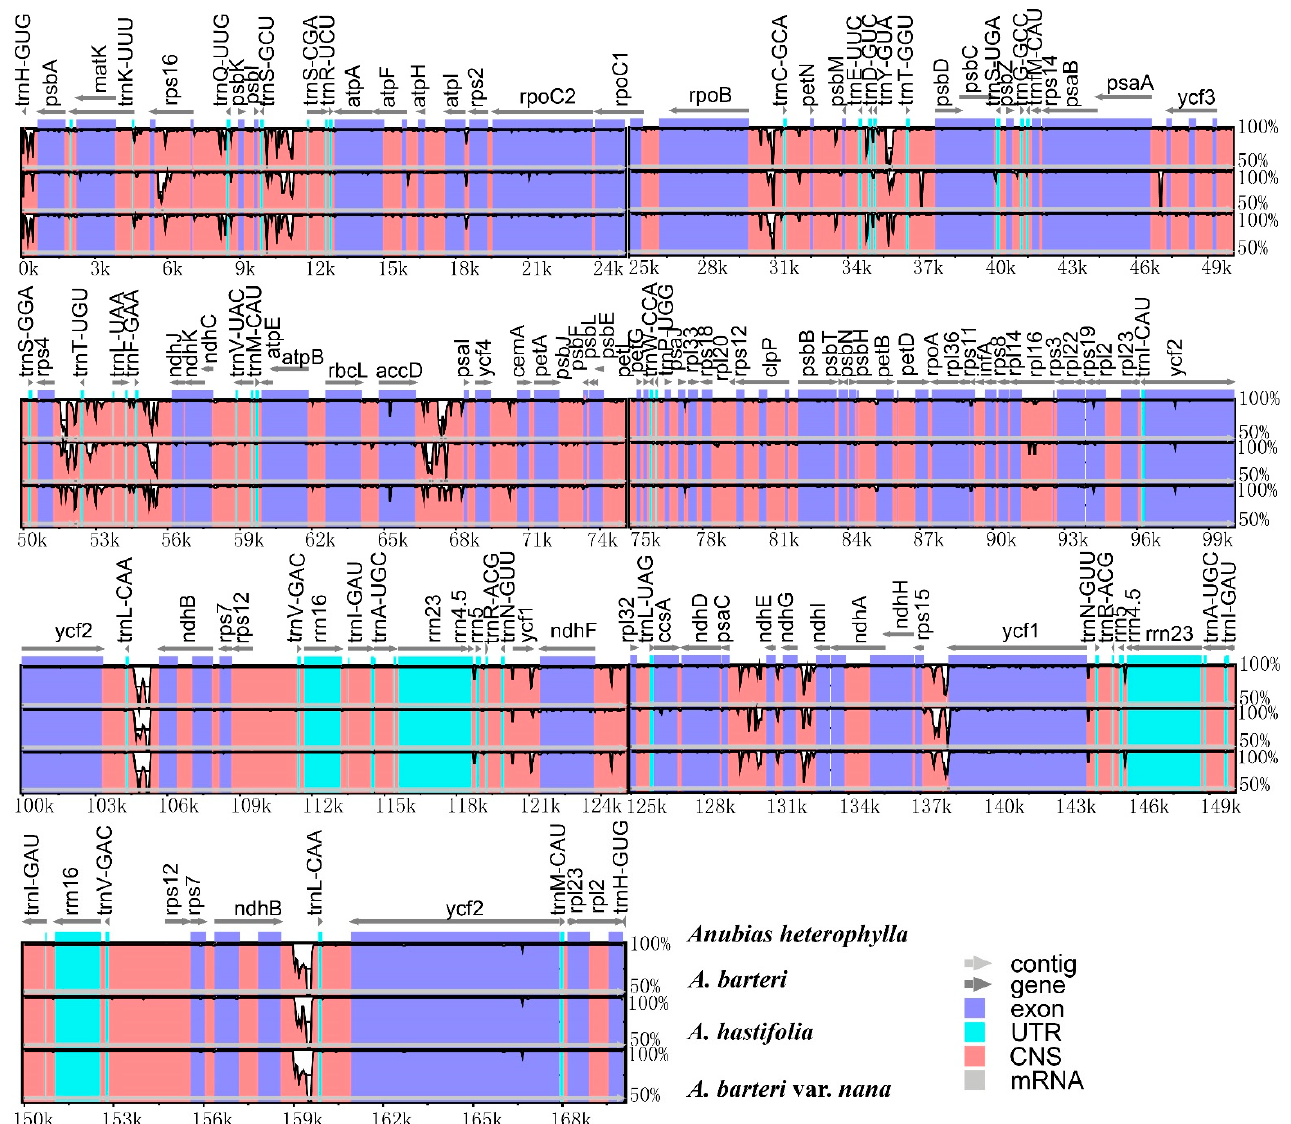
Figure 3. Alignment visualization of four Anubias plastomes with the mVISTA program.